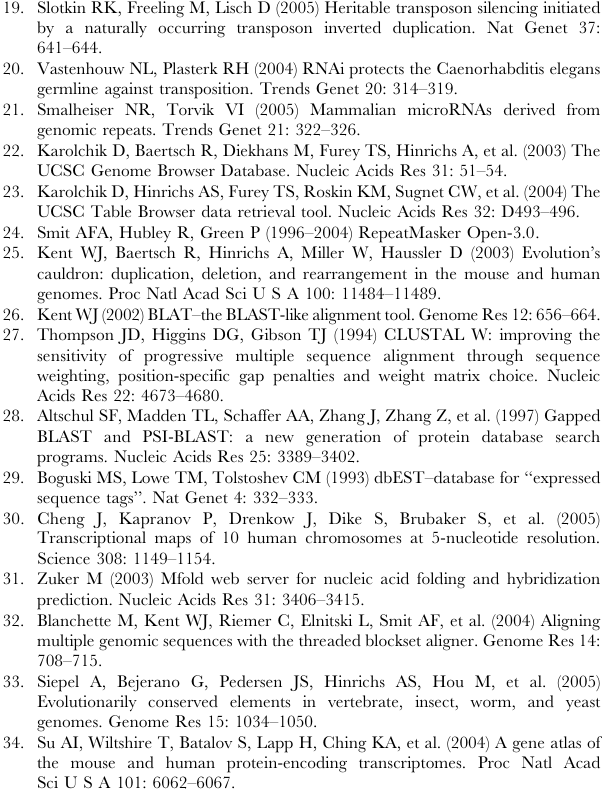
Figure S2 Over-represented GO biological process categories among genes with miRanda predicted hsa-mir-548 target sites that map to colorectal cancer down-regulated co-expression clusters (i.e. 12, 15 & 20 in Figure 6). The portion of the directed acyclic graph (DAG) containing all paths from the root biological process term to the over-represented functional category terms is shown. Over-represented functional categories are indicated in red. Figure S3 Made1-derived miRNA genes are primate-specific. Human genomic regions corresponding to Made1-derived miRNA genes are shown: A hsa-mir-548a-1, B hsa-mir-548-a2, C hsa-mir-548-a3, D hsa-mir-548-b, E hsa-mir-548-c, F-hsa-mir- 548-d1, G-hsa-mir-548-d2. The UCSC Genome Browser is used to show the location of the Made1 elements (DNA) in the RepeatMasker track. Evolutionary comparisons between the human genome and the corresponding regions in the chimp, rhesus, mouse, rat, dog and cow genomes are shown using the species-specific Net tracks of the Genome Browser. Corresponding Made1 orthologous regions that are present in another species are indicated with a broad line, while regions that are missing in another species are shown with a thin line.